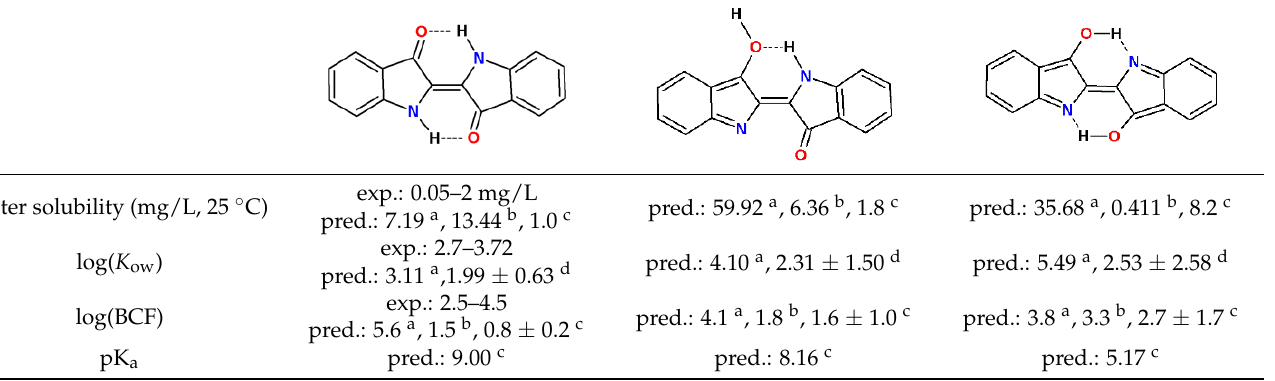
Table 1. E-indigo tautomers with experimental data [10,33,47–50] and QSAR predicted properties